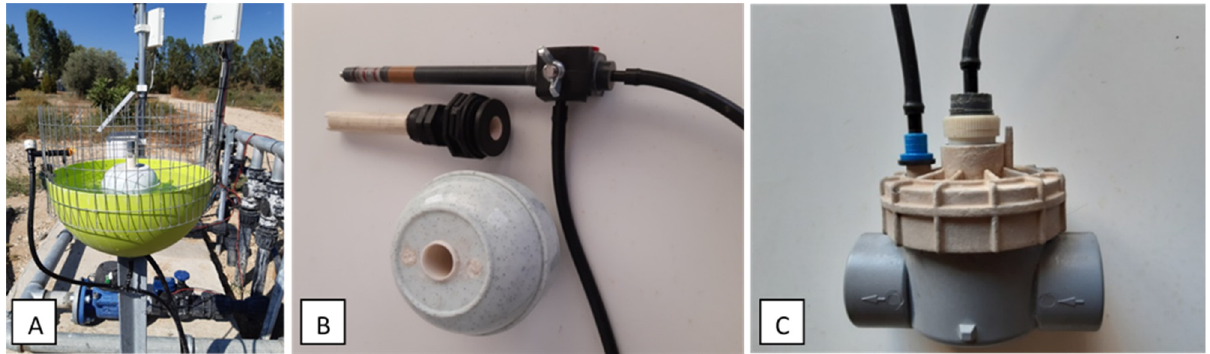
Figure 1. Drawing details of a Hydraulic Evapotranspiration Multisensor.